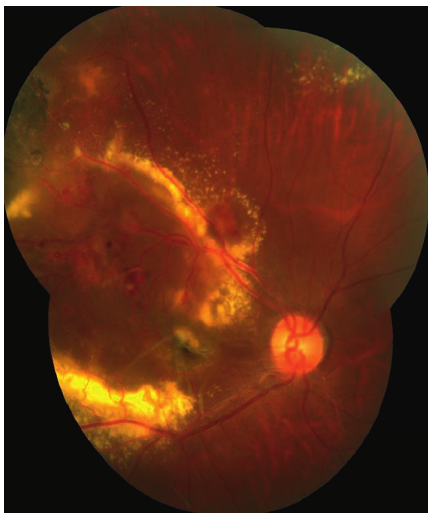
Figure 1: Color fundus photograph of a 40-year-old male patient (Case 4) in the DEX (+) group. The figure shows the right eye diagnosed with Coats’ disease classified as Stage 3A. The baseline visual acuity of this patient was FC/30cm. Retinal telangiectasia, microaneurysms, massive hard exudates, and exudative retinal detachment can be observed at the posterior